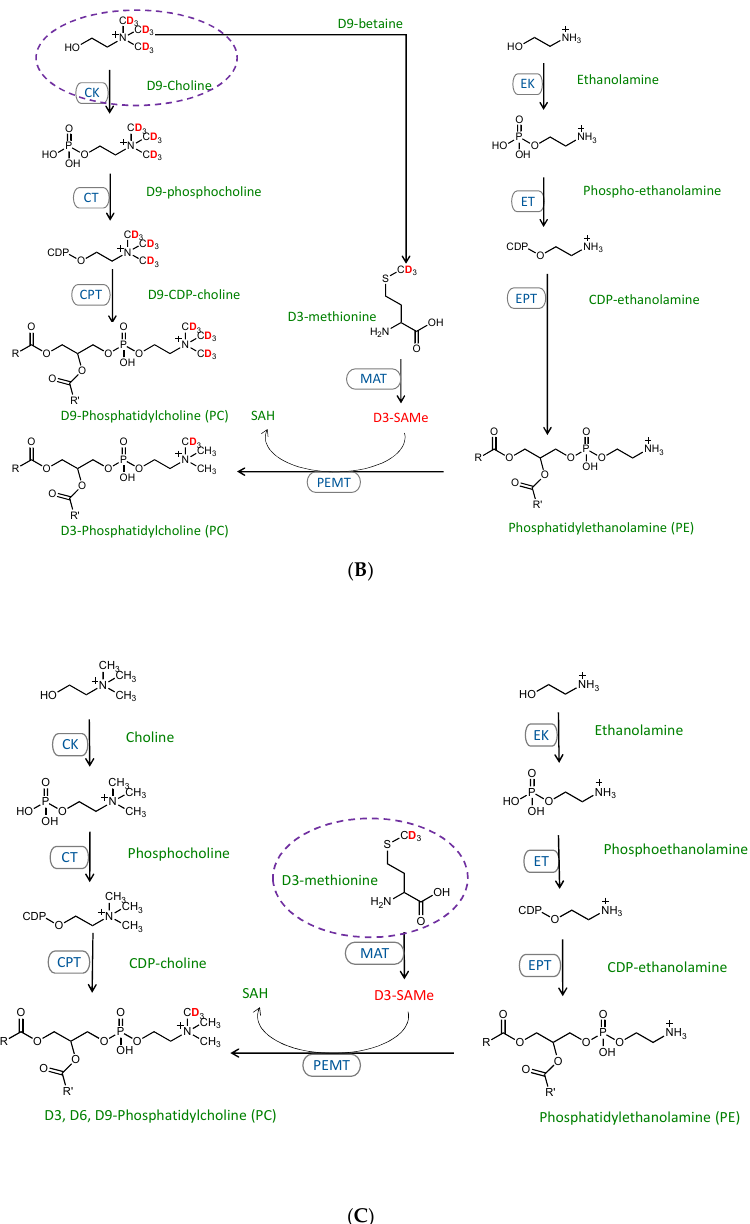
Figure 3. Schematic representations of traced phospholipid biosynthetic pathways in this study. Selected PC and PE biosynthetic pathways relevant to this study were obtained from the literature and the KEGG Pathway Database (https://www.kegg.jp/kegg/pathway.html; 15 January 2021). The deuterated tracers (D4-ethanolamine, D3-methionine, and D9-choline) used to substitute their hydrogenated counterparts in cell culture media are circled and the pathways they participate in are detailed. D4-ethanolamine traces the CDP-ethanolamine pathway ( A ); D9-choline can be used to trace methionine, via betaine aldehyde and betaine [13,14,16], as shown in panel ( B) . D3-methionine